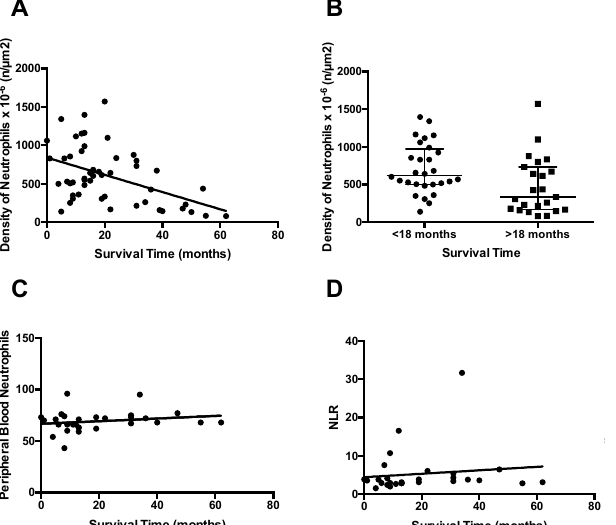
Figure 5. ( A ) Correlation analyses of ADAM8 + neutrophil counts in post-capillary venules. Each data point is the average of 3 independent post-capillary venules of an area > 2000 μ m 2 in the core tumor tissue ( n = 50). Pearson correlation revealed r = − 0.463 with p = 0.0006. ( B ) Neutrophil density diagram from our PDAC patient cohort split into survival time less than and greater than 18 months, p = 0.0128. ( C ) Neutrophil counts in peripheral blood of PDAC patients from the same cohort, p = 0.2797. ( D ) Neutrophil-to-lymphocyte ratio in the PDAC patient cohort, p = 0.5143. Note that only the ADAM8 + neutrophil counts in post-capillary venules are significantly correlated with PDAC patient